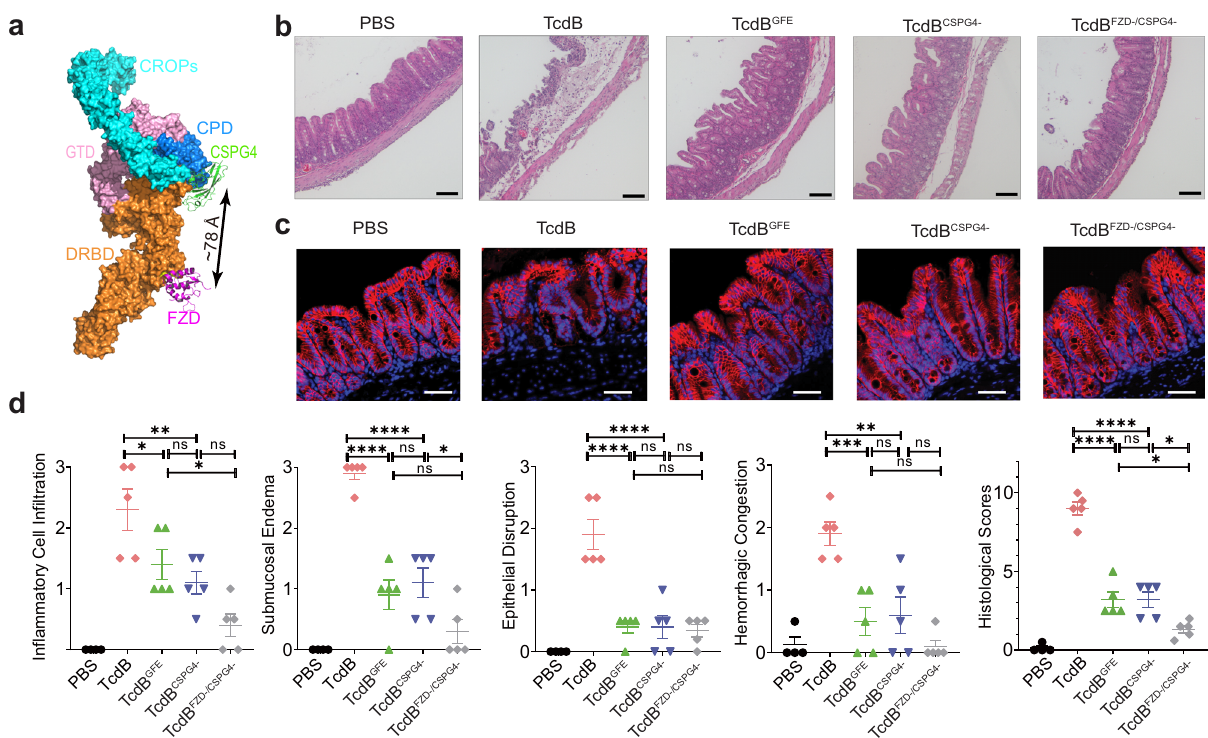
Fig. 5 Mutations selectively abolishing CSPG4 or FZD binding reduce toxicity of TcdB on cecum tissues. a A structural model of TcdB holotoxin with CSPG4 and FZD bound at two independent sites. The model is built based on superposition of the structures of TcdB1 holotoxin (PDB: 6OQ5), the TcdB – FZD complex (PDB: 6C0B), and the TcdB – CSPG4 complex (this work). b – d The indicated TcdB mutants or the control PBS was injected into the cecum of CD1 mice in vivo. The cecum tissues were harvested 6 h later and subjected to histological analysis with representative images (scale bars represent 100 µ m, PBS n = 4, TcdB n = 5, TcdB GFE n = 5, and TcdB FZD − /CSPG4 − n = 5, TcdB CSPG4 − n = 5) ( b ), immunostaining analysis for the tight junction marker Claudin-3 (scale bars represent 50 µ m, PBS n = 3, TcdB n = 3, TcdB GFE n = 3, and TcdB FZD − /CSPG4 − n = 3, TcdB CSPG4 − n = 3) ( c ), and pathological scores (error bars indicate mean ± SEM, PBS n = 4, TcdB n = 5, TcdB GFE n = 5, and TcdB FZD − /CSPG4 − n = 5, TcdB CSPG4 − n = 5) ( d ). p values were calculated by post hoc analysis of a by one-way ANOVA using Holm-Sidak ’ s test for multiple comparisons: **** p ≤ 0.0001, *** p ≤ 0.001, ** p ≤ 0.01, * p ≤ 0.05. The exact p values are presented in the accompanying source